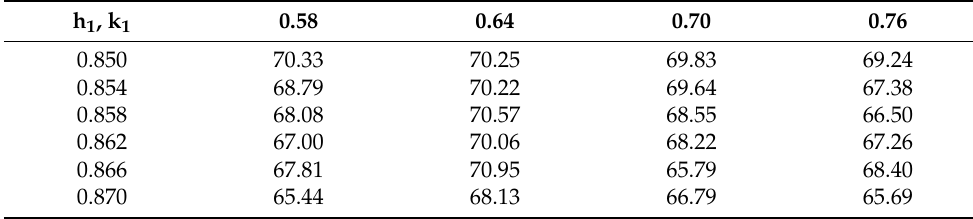
Figure 23. Variable definition of core. Table 2. Result of ASPL (dB) under different cases.